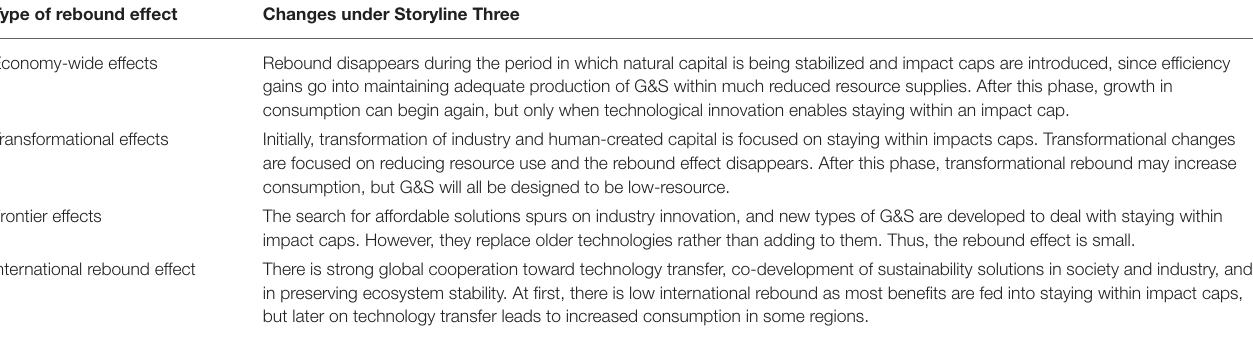
TABLE 6 | Storyline three changes in four types of macro-level rebound